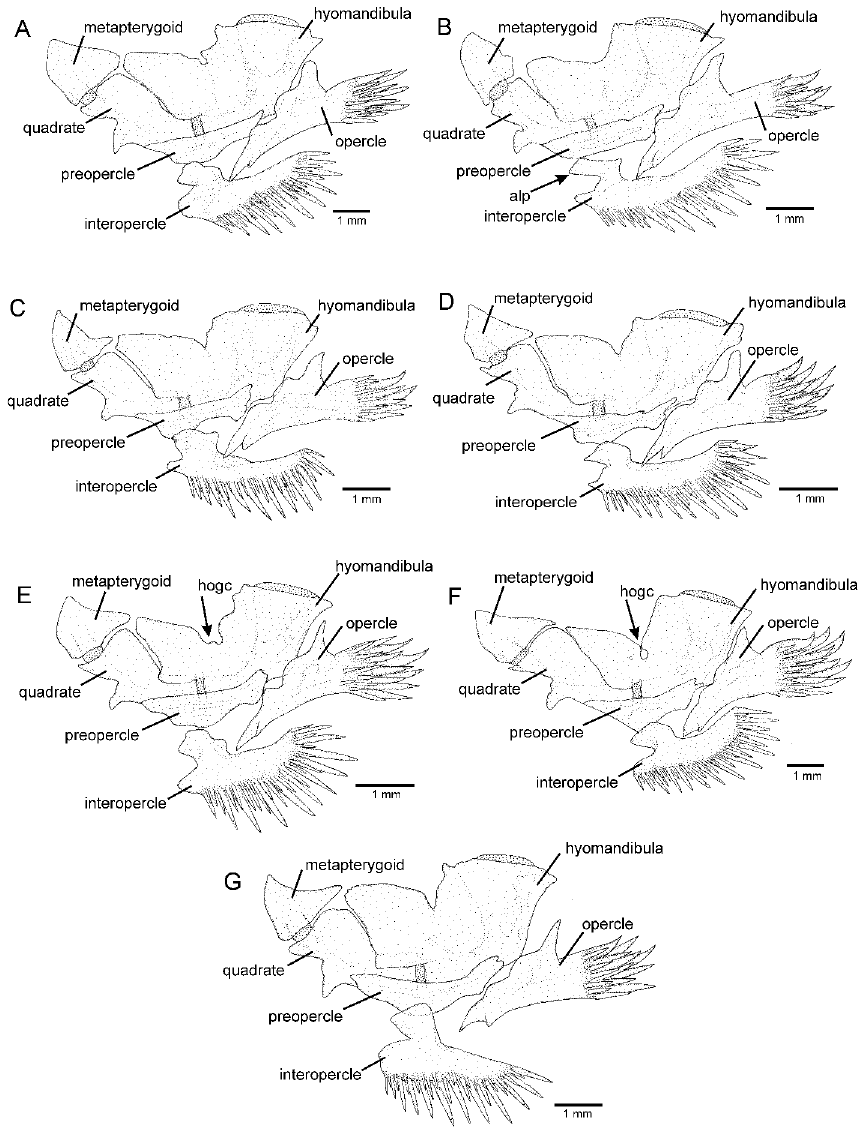
Figure 4. Left jaw suspensorium and opercular series, lateral view: ( A ) Trichomycterus auroguttatus ; ( B ) Trichomycterus longibarbatus ; ( C ) Trichomycterus puriventris ; ( D ) Trichomycterus saquarema Costa, Katz, Vilardo and Amorim, sp. nov.; ( E ) Trichomycterus travassosi ; ( F ) Trichomycterus altipombensis Costa, Katz, Vilardo and Mattos, sp. nov.; ( G ) Trichomycterus jacupiranga . Larger stippling represents cartilages. alp, axe-like process; hogc, hyomandibular outgrow cleft. The two species endemic to the RPSA occur in two disjunct areas, both between about 800 and 1200 m asl, with T. auroguttatus being endemic to the upper Rio Preto drainage, a large left tributary to the Rio Paraíba do Sul basin, with headwaters in the Serra da Man- tiqueira, and T. goeldii occurring in a broad area of the middle Rio Paraíba do Sul basin, with headwaters in the Serra do Mar (Figure 5). Trichomycterus auroguttatus (Figure 6) is distinguished from T. alternatus (Figure 7) and T. goeldii (Figure 8) by the presence of a shorter nasal barbel, its tip reaching area immediately posterior to orbit (vs. area just an- terior to opercle); a larger eye that is always larger than the opercular patch of odontodes (vs. nearly equal in size); supraorbital canal usually interrupted, forming two separate segments, resulting in the presence of two s3 pores (Figure 9A; vs. supraorbital canal con- tinuous, with a single s3 pore, Figure 9B); and brown spots of the anterior portion of a row of spots on the longitudinal midline of flank deeper than long, separated by broader in- terspaces, never forming a stripe (vs. longer than deep, separated among themselves by